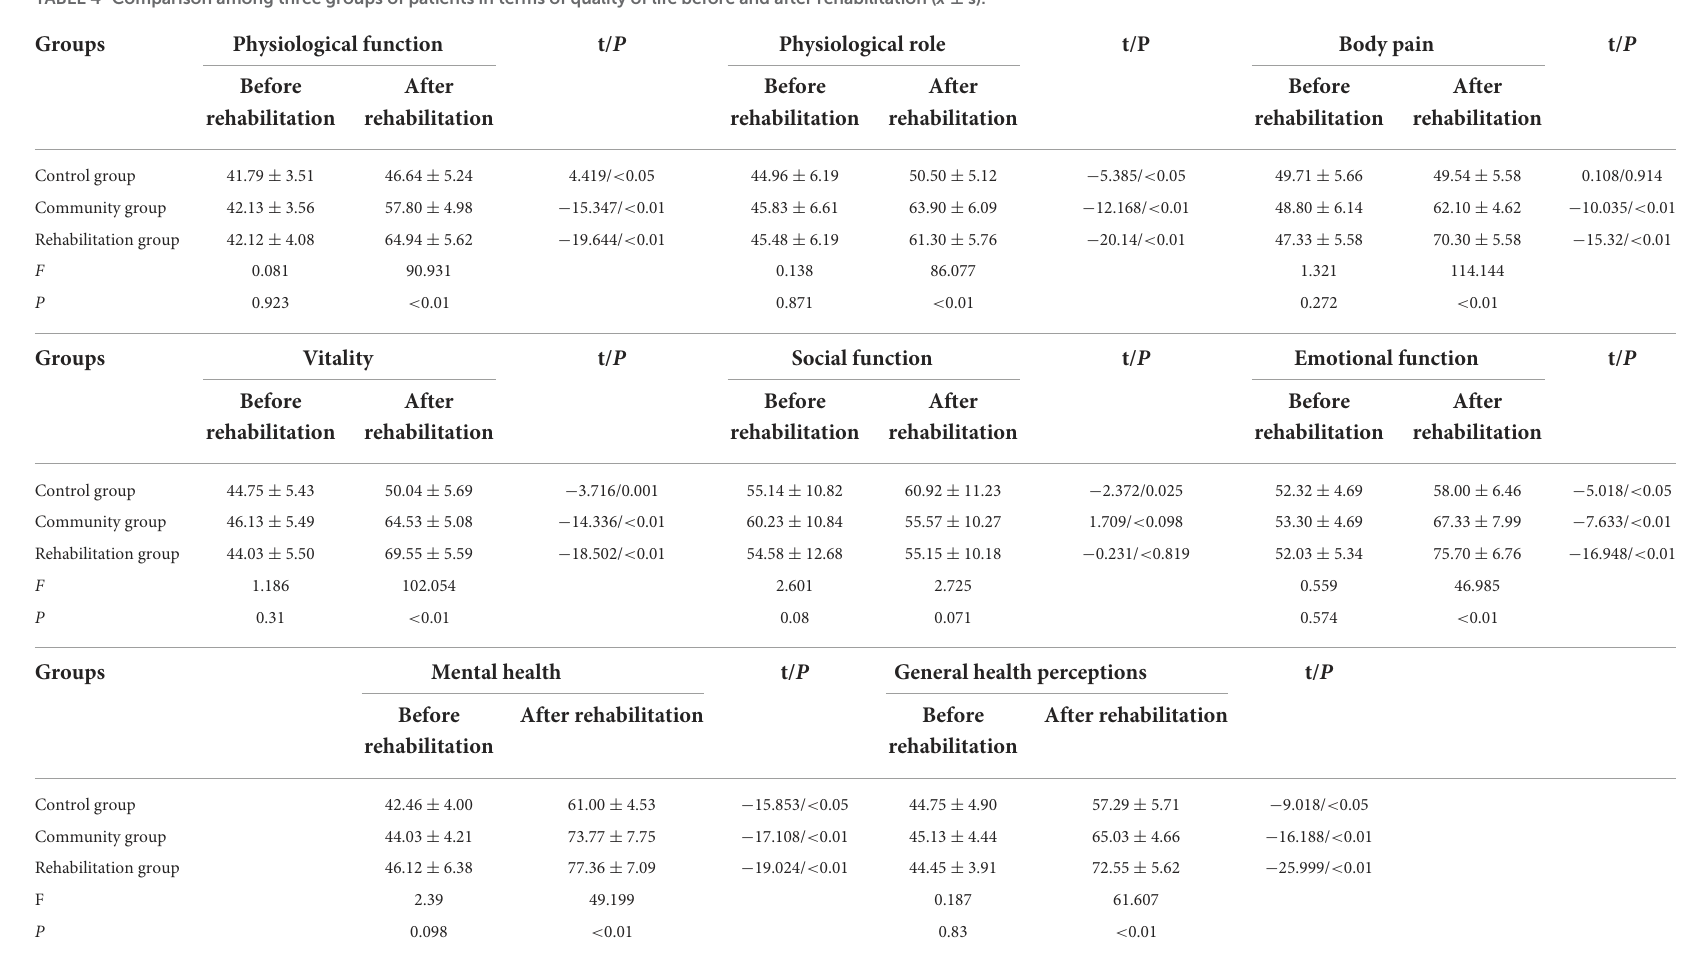
TABLE 4 Comparison among three groups of patients in terms of quality of life before and after rehabilitation ( ¯ x ± s). Groups Physiological function t/ P Physiological role t/P Body pain t/ P Before After rehabilitation rehabilitation